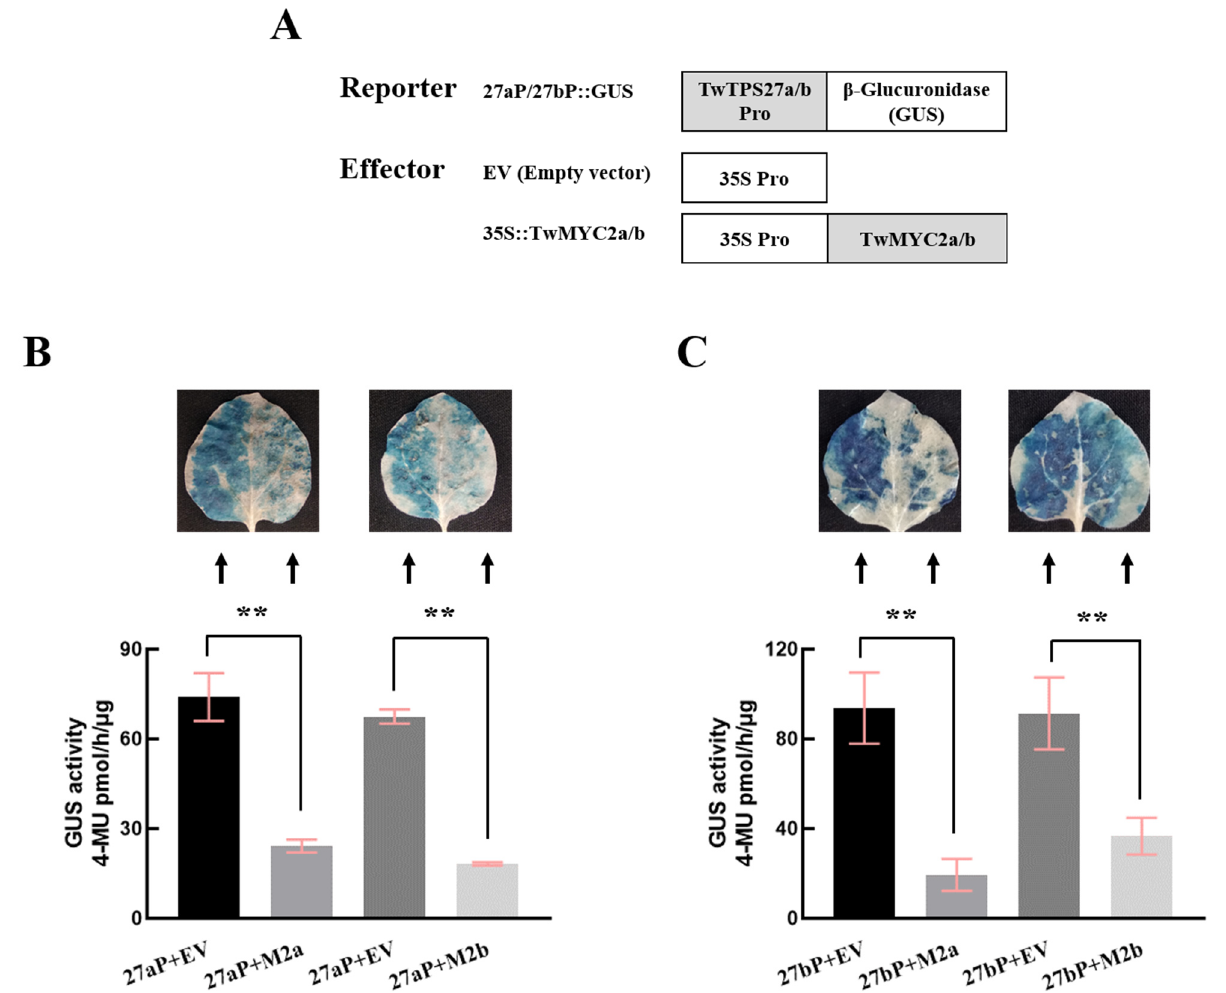
Figure 3. Repression of the TwTPS27a and TwTPS27b promoters by transient overexpression of TwMYC2a and TwMYC2b in tobacco leaves. ( A ) Sketch map of the reporter and effector vectors for GUS staining and GUS fluorimetric assays. 27aP::GUS and 27bP::GUS represent the promoter expression vectors constructed by introducing the promoter sequences of TwTPS27a (1496 bp) and TwTPS27b (1862 bp) into the pBI121 vector, respectively. Based on the GUS staining and GUS fluorimetric analysis of the infiltrated tobacco leaves, TwMYC2a and TwMYC2b significantly decreased the promoter activity of TwTPS27a ( B ) and TwTPS27b ( C ). Different combinations of the mixed bacterial suspension were infiltrated into the left and right sides of the same tobacco leaves, respectively. 27aP and 27bP represent the 27aP::GUS and 27bP::GUS. M2a and M2b represent the 35S::TwMYC2a and 35S::TwMYC2b. GUS activity of the infiltrated leaves was measured after infiltration for 72 h. The value of GUS activity was measured as pmol of 4-MU generated per hour per μ g protein. All data presented here are means ± SD of three biological replicates. Statistical significance was determined by Student’s t -test (** p < 0.01). These assays were repeated three times with similar results.